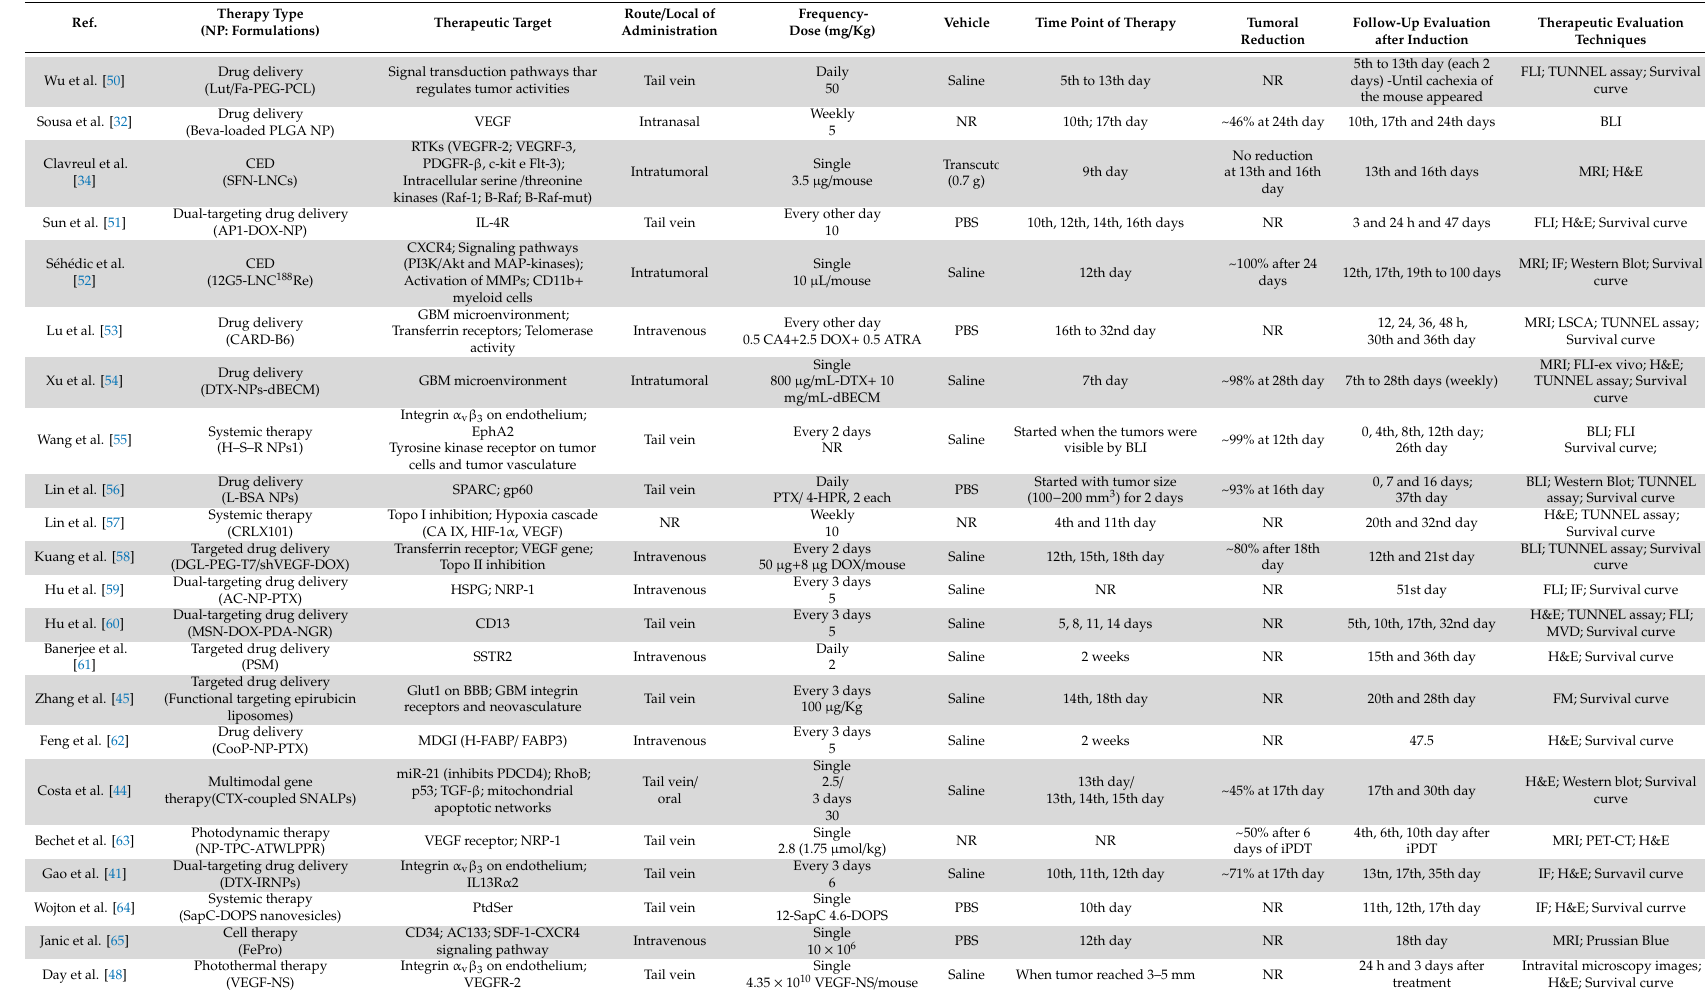
Table 4. Antiangiogenic therapeutic process for